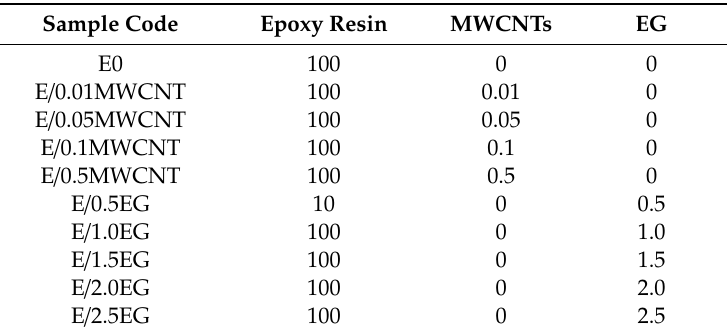
Table 1. Formulations of epoxy composites